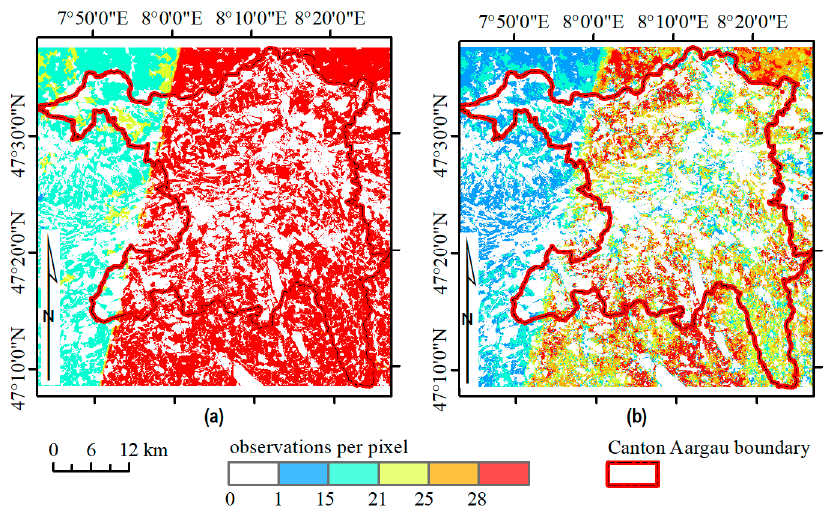
Figure 4. Number of observations per pixel in: ( a ) standard TS; and ( b ) optimized TS. The white areas were excluded from the analysis. The eastern part of the study area is covered by much denser time series, due to overlap between Sentinel-2 stripes.